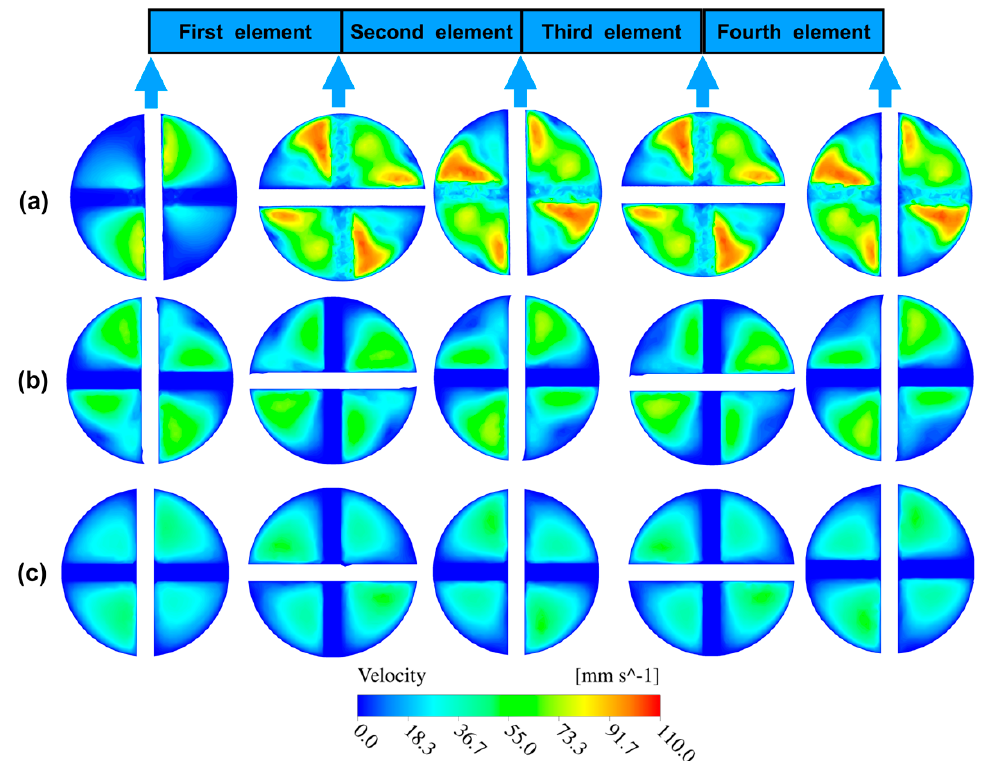
Figure 7. Effect of aspect ratio on cross sectional profiles of velocity at Re = 100: ( a ) AR = 0.4; ( b ) AR = 0.8; ( c ) AR = 1.5.